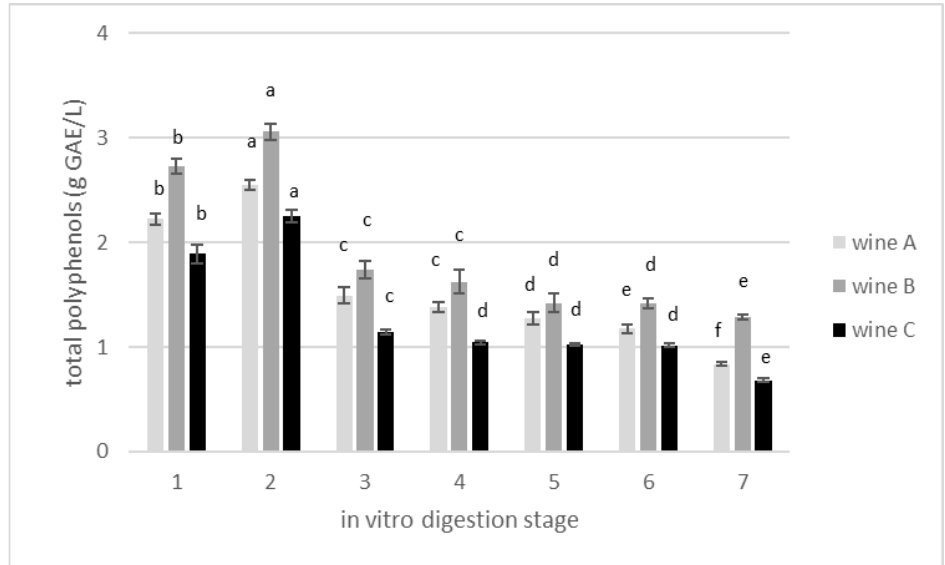
Figure 3. Changes in total polyphenol concentration expressed as gallic acid equivalent (g GAE/L)